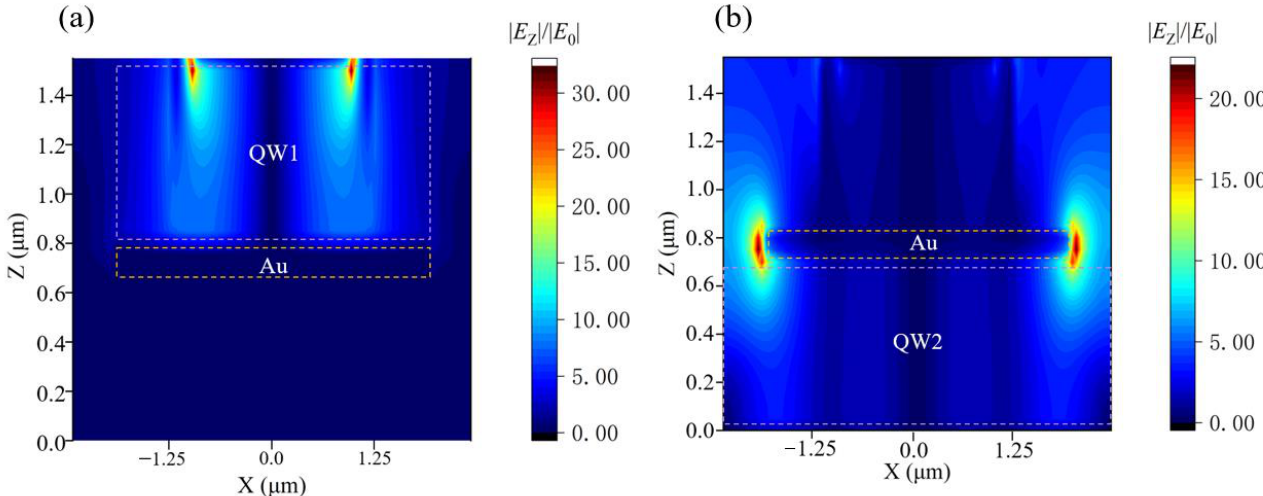
Figure 3. | E Z | / | E 0 | distributions of the two quantum well layers in the x-z plane ( y = 0) at 13.2 and 11.0 µ m: ( a ) | E Z | / | E 0 | distribution of the quantum well working at 13.2 µ m, ( b ) | E Z | / | E 0 | distribution of the quantum well working at 11.0 µ m, the purple dashed line indicates the active region of the quantum well.